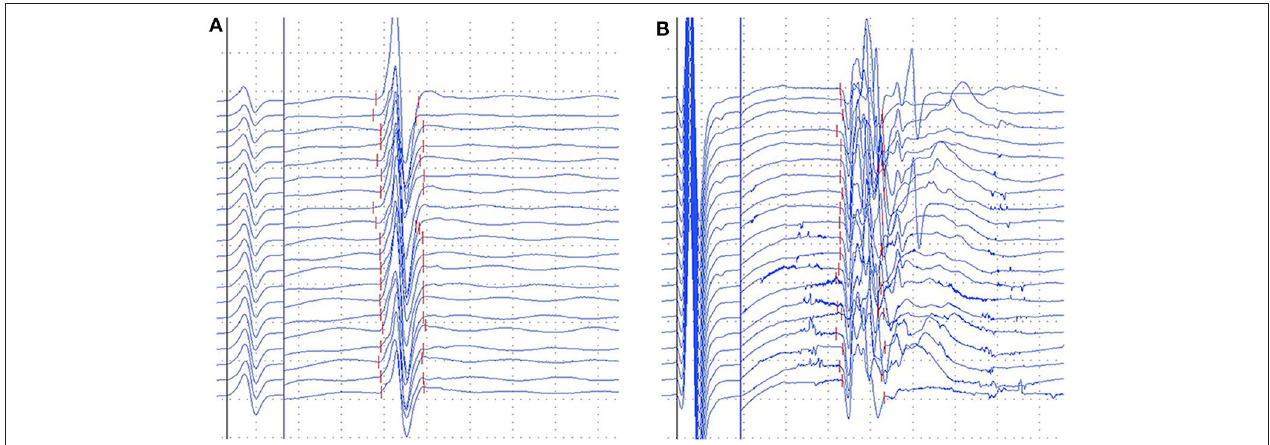
FIGURE 1 | Representative images of gaint F-waves in the preclinical carriers and SCA3 patients. (A) gaint F-waves of tibial nerve in the preclinical carriers with 92.1% persistence; (B) gaint F-waves of tibial nerve in the SCA3 patients with 67.5% persistence. Dural gain was used; during the M-wave, the gain was 5 mV/div, and during the F-wave, the gain was 0.5